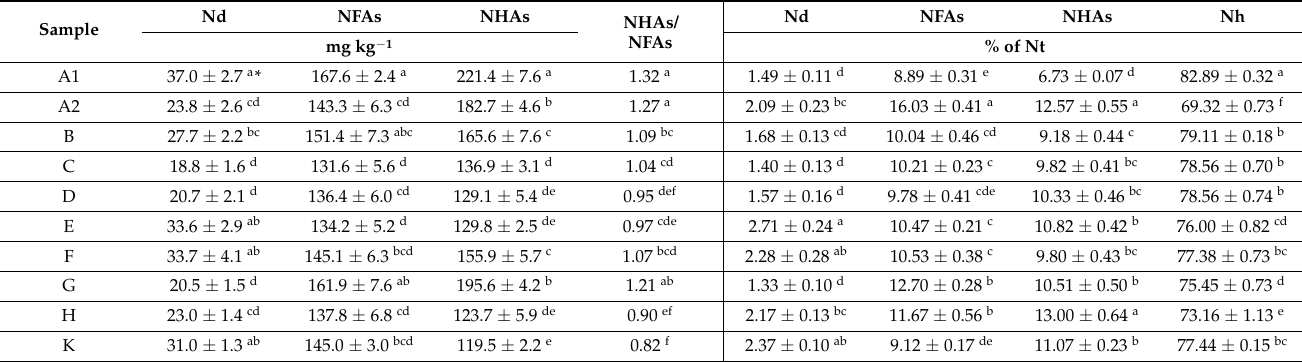
Table 5. Content and share of nitrogen in humus